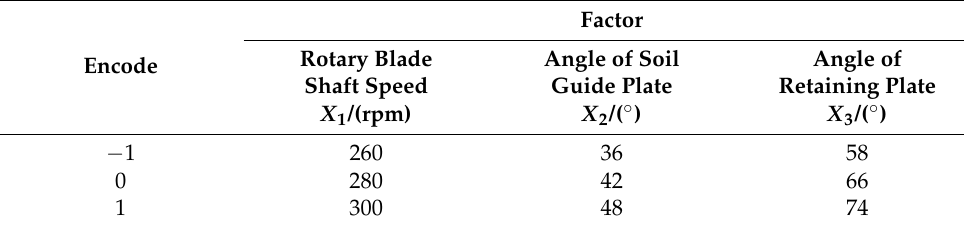
Table 3. Test Factors and